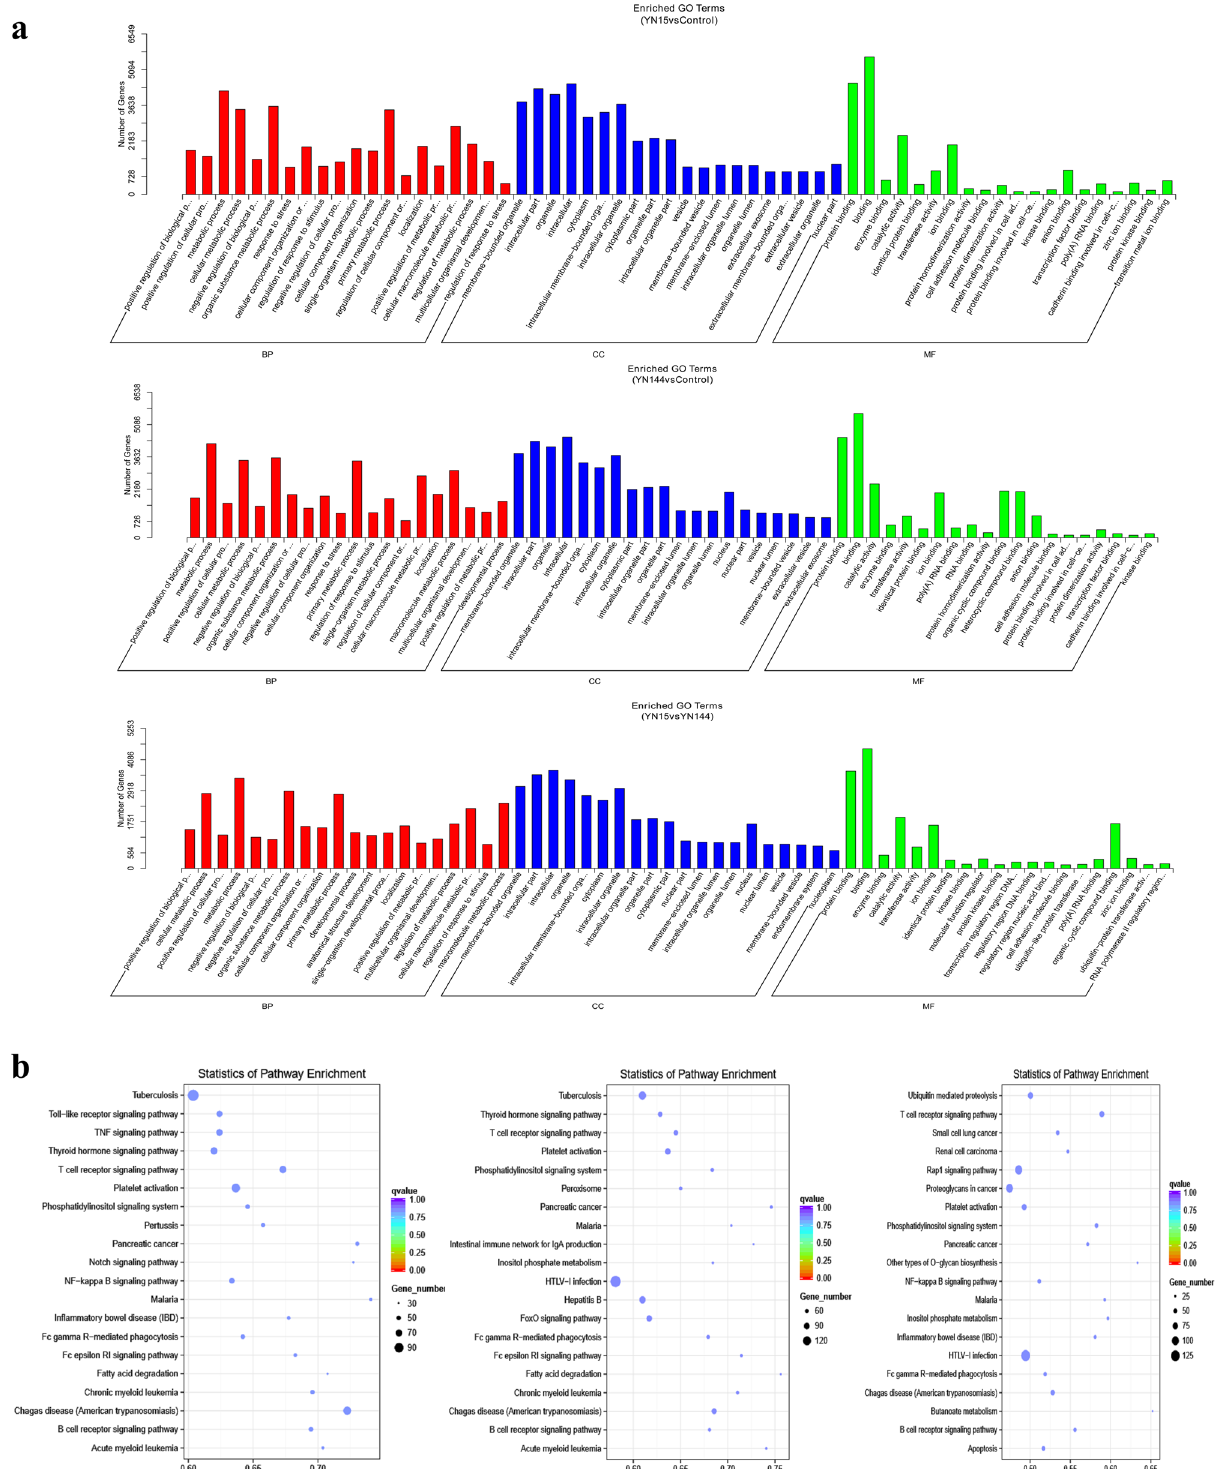
Figure 4. DE miRNAs and their predicted target mRNAs in PEDV-infected ST cells. ( a ) GO analysis of the predicted target genes of the DE miRNAs from the three comparison groups. ( b ) KEGG analysis of the predicted target genes of the DE miRNAs from the three comparison groups. Each panels indicates the top 20 significantly enriched pathways identifed by KEGG analysis of each of the three comparison groups (Left, YN15 vs Control; Middle, YN144 vs Control; Right, YN15 vs